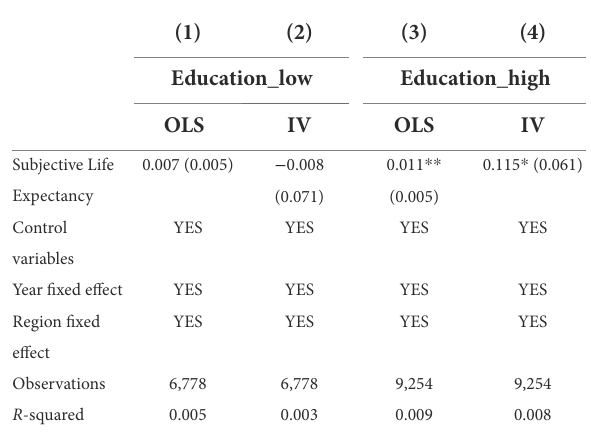
TABLE 5 Urban–rural heterogeneity. TABLE 6 Education heterogeneity.